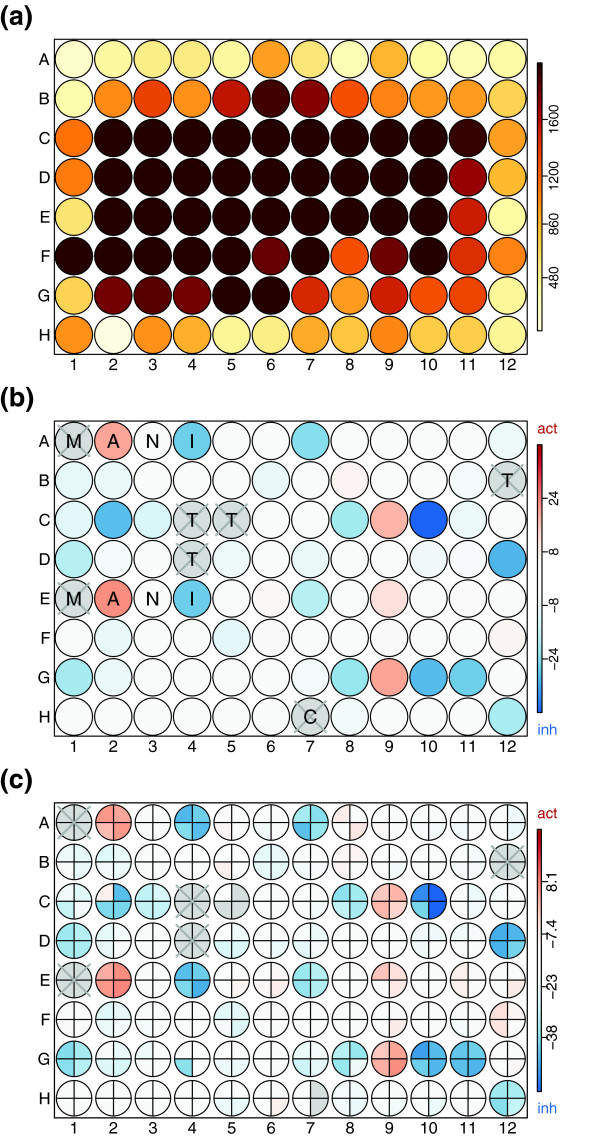
Plate plots show several aspects of the data in a format resembling a microtiter plate. This is useful for detecting spatial effects and to present concisely the data belonging to one experiment. (a) Quantitative values: number of cells in the well. The consistently lower number of cells at the edges of the plate indicate problems during cultivation. (b) Qualitative values: activators (red) and inhibitors (blue) of the process of interest. Wells that did not pass quality requirements are crossed out and wells containing cells treated with controls are indicated by capital letters. Cells in the first four rows of the plate were transfected with amino-terminally tagged expression constructs, and rows five to eight with carboxyl-terminally tagged constructs. (c) Comparison of results from four replicate plates. Each slice contains data from one replicate. Reproducibility between replicates is very high.